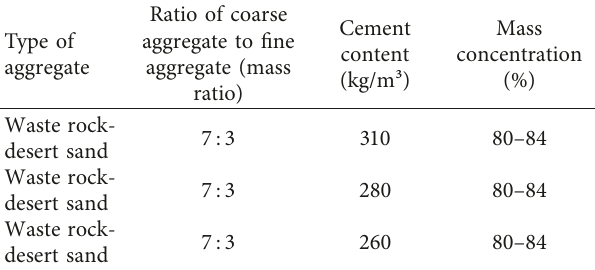
Figure 7: Gradation of Jinchuan filling aggregate. Table 3: Homogeneity test of slurry.